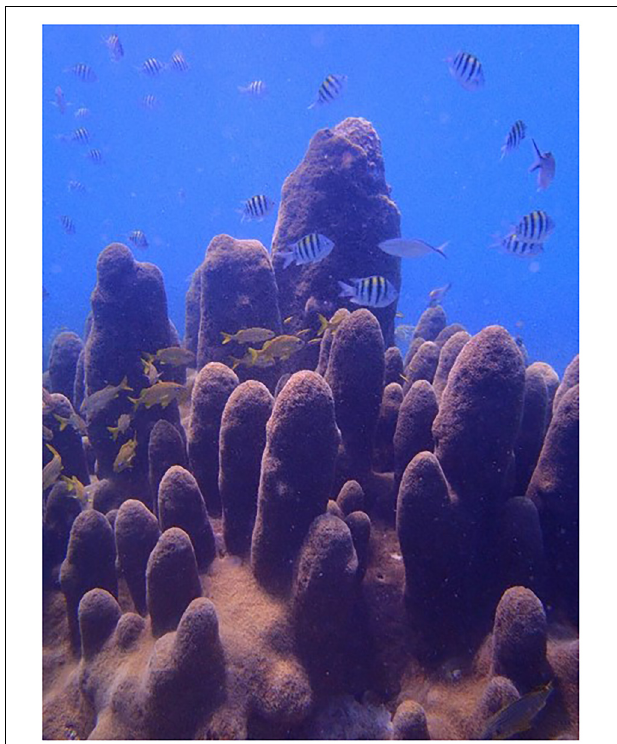
FIGURE 1 | The iconic pillar coral, Dendrogyra cylindrus. This unique species occurs in historically low abundance throughout the Greater Caribbean. Its unique columnar structure provides important habitat complexity to the reef ecosystem where it does occur (Photo: C.